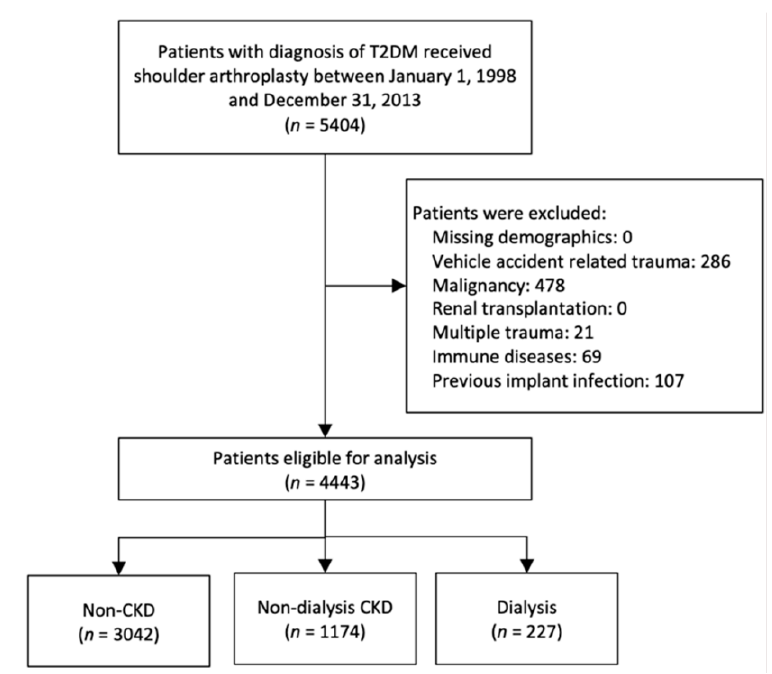
Figure 1. Flowchart for patient